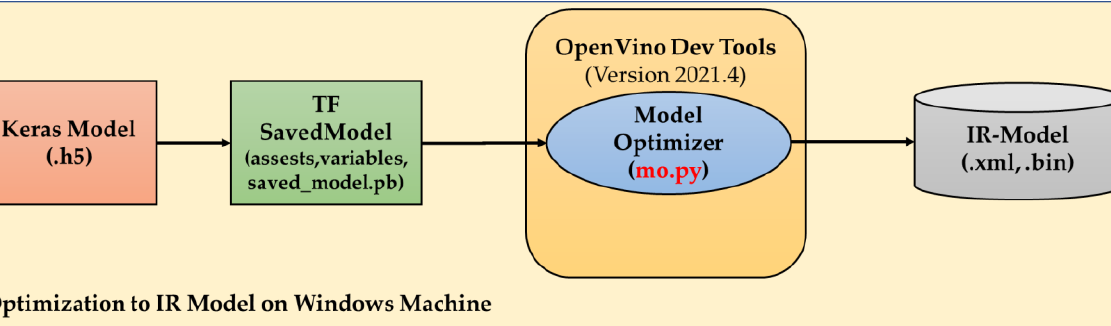
Figure 7. High-level representation of the Keras model to IR model conversion through the TF saved model and model optimiser.